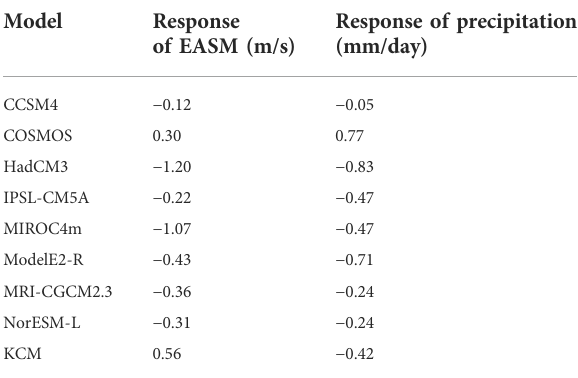
TABLE 3Theresponse(de fi ned asthedifference betweenPre-indurial and Plio) of the intensity of East Asian summer monsoon